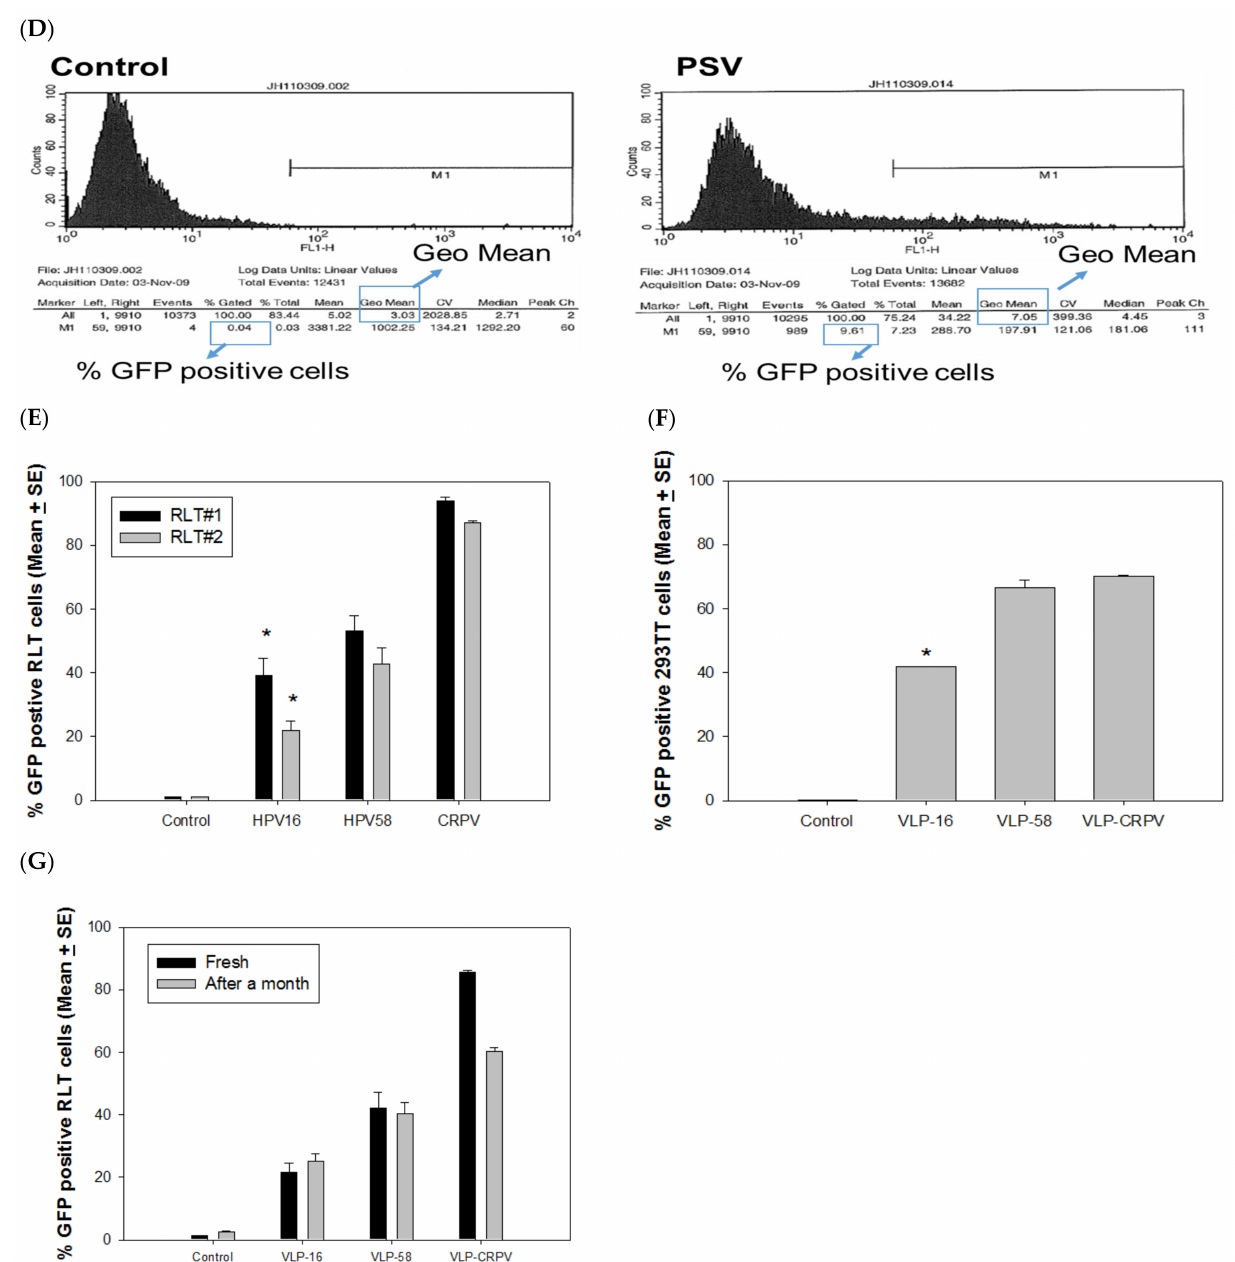
Figure 1. ( A ) Using HPV58 VLPs as an example, L1 and L2 contents were determined by ELISA assay using type- specific antibodies against L1 (H58.G5) and a cross-reacting rabbit antibody against L2 (R972). The corresponding protein concentration in each fraction was also determined by Bio-Rad protein assay (right axis mg/mL). ( B ) VLPs visualized by TEM should be empty particles, but many particles were filled with cellular DNAs and appear full. ( C ) GFP expression in rabbit cells (RLT) by HPV 16 and 58 L1-only VLPs and PSVs. As shown in the top panel, HPV 16 and 58 L1-only VLPs failed to deliver attached GFP into cultured cells. By contrast, GFP-positive cells were found when 16-PSV and 58-PSV delivered attached GFP DNA. 58-PSV showed comparable GFP expression to the commercial transfection kit. ( D ) Flow cytometry analysis was used to quantify GFP signals. Two parameters, the percentage of GFP positive population and mean fluorescent intensity (MFI) by geometric mean were analyzed, as shown here in a typical dataset. These two parameters correlated with each other and thus were used interchangeably for comparison among groups. ( E ) Significantly fewer rabbit cells (cell lines from two different rabbits) were GFP-positive by VLP-16 delivery when compared to HPV58- and CRPV-VLPs ( p < 0.05, unpaired Mann Whitney test, indicated by *). ( F ) We tested delivery of GFP DNA by HPV58-,